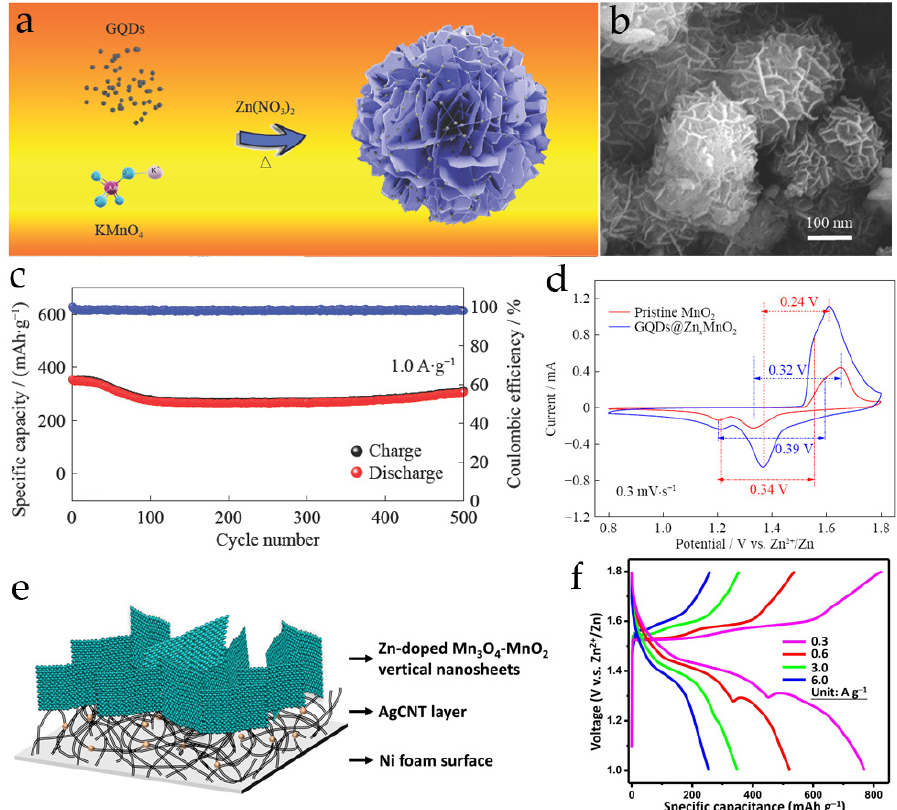
Figure 5. ( a ) Scheme of the synthesis route for GQDs@Zn x MnO 2 composite [42]. ( b ) SEM image of GQDs@Zn x MnO 2 [42]. ( c ) Long-term cycling of GQDs@Zn x MnO 2 electrode [42]. ( d ) Comparison